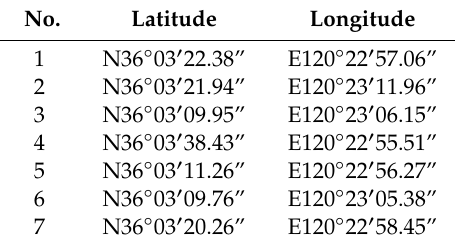
Table A2. Location coordinates of 25 planned